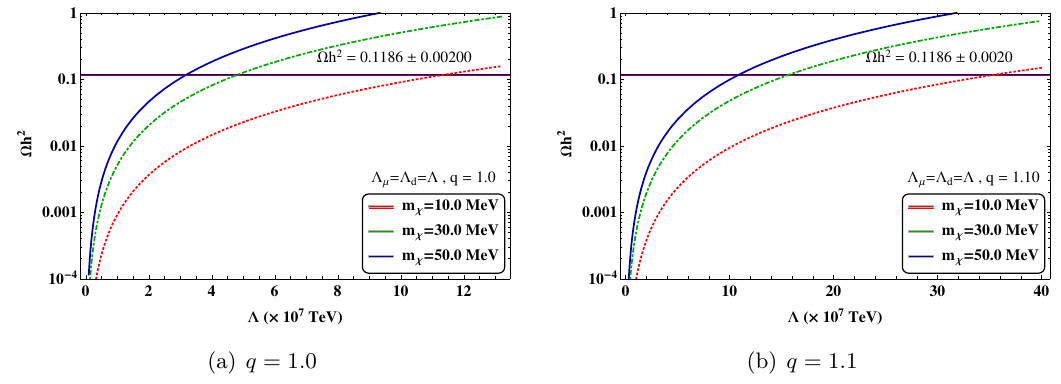
Figure 5 . (cid:10) h 2 is plotted against (cid:3) (in TeV) for q = 1 and q = 1 : 1 and di(cid:11)erent m (cid:31)